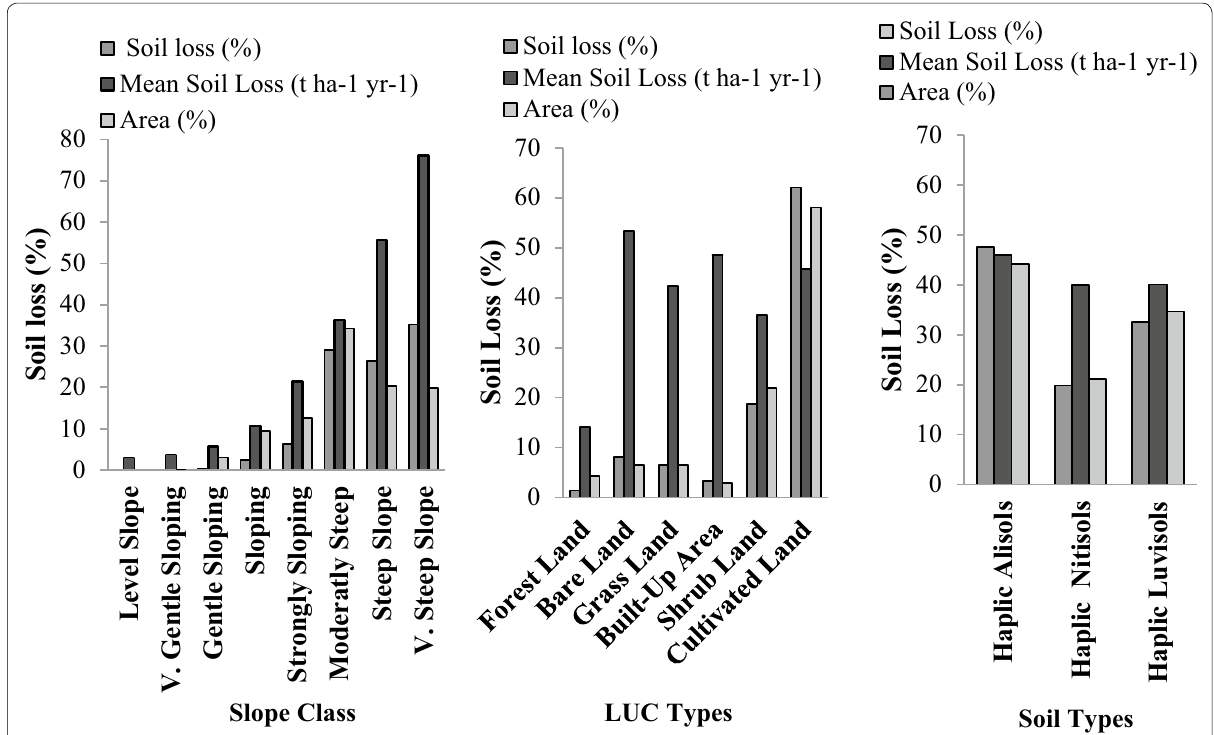
Fig. 6 Soil loss with respect to slope, land use/cover and soil types in Gumara